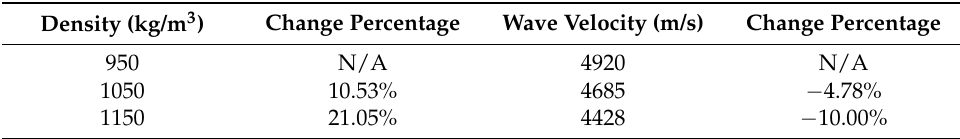
Figure 17. Wave propagation behaviours with different densities in orthotropic model. Table 6. Parametric study of density for isotropic material model.